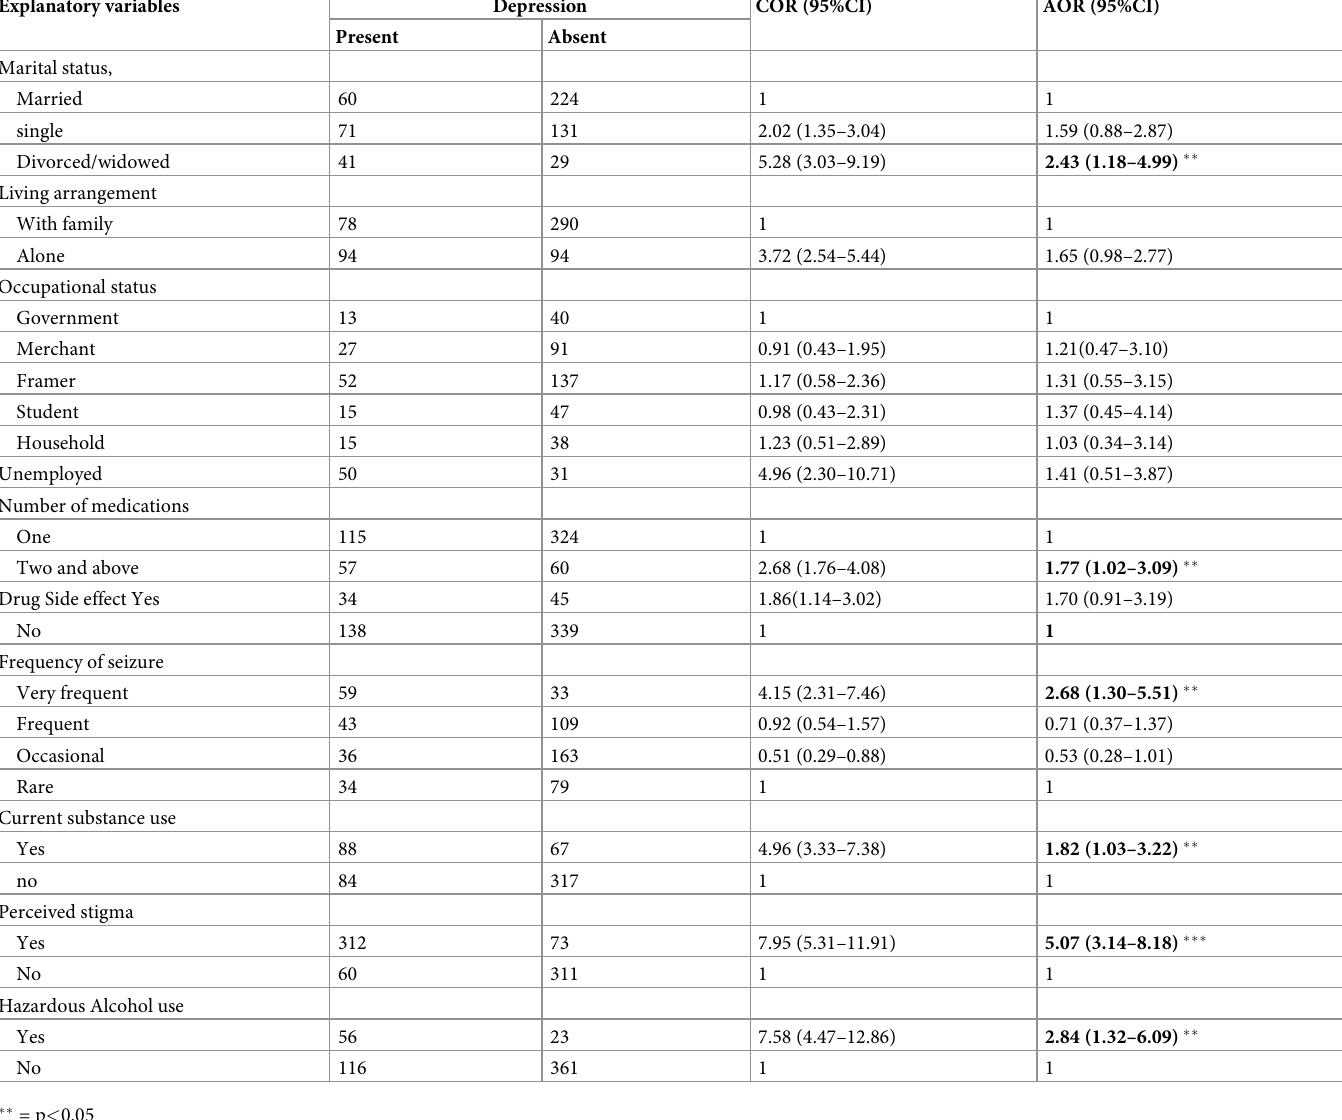
Table 3. Factors associated with depression in bivariate and multivariate logistic regression analysis among people with epilepsy at enteral Gondar zone primary public hospitals, northern part of Ethiopia (n =